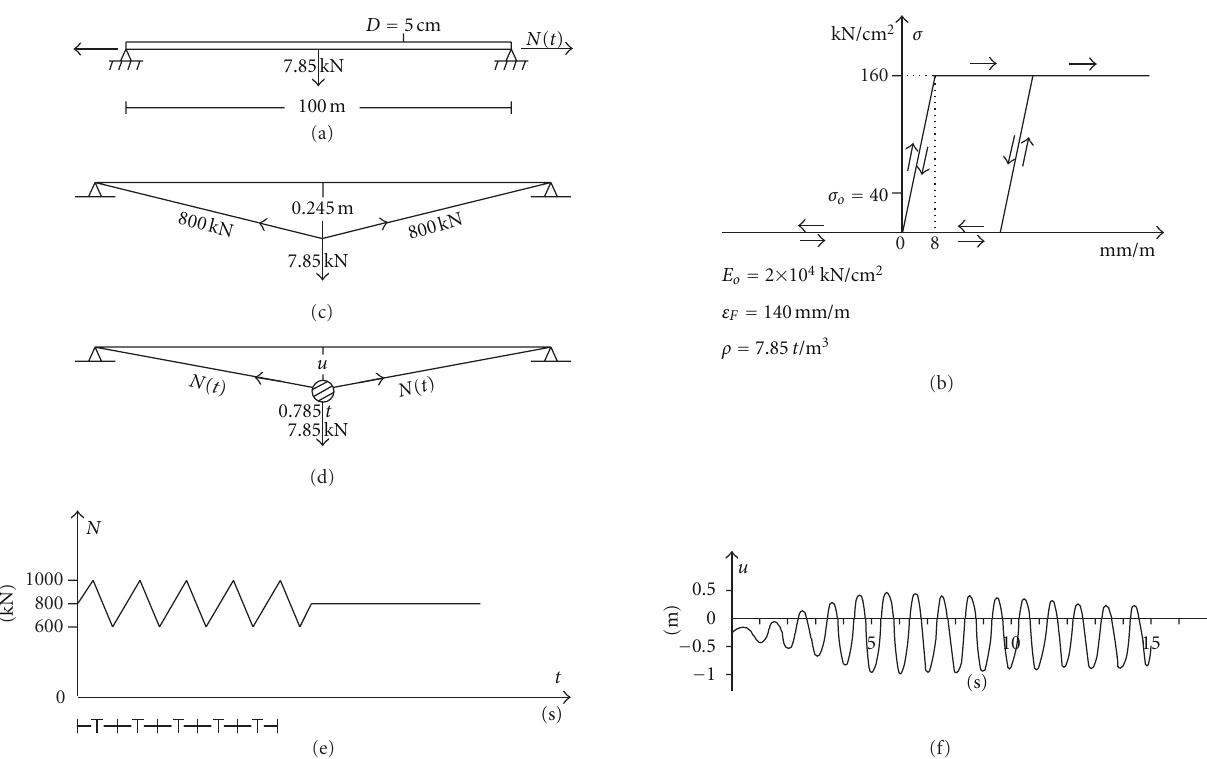
Figure 3: First application: isolated cable subject to tra ffi c. (a) Given geometry and loading. (b) Axial stress-strain diagram of high-strength steel. (c) Initial static analysis. (d) Parameters of dynamic analysis. (e) Given time-history N ( t ) of axial force of cable. (f) Resulting time- history u ( t ) of vertical displacement at center of